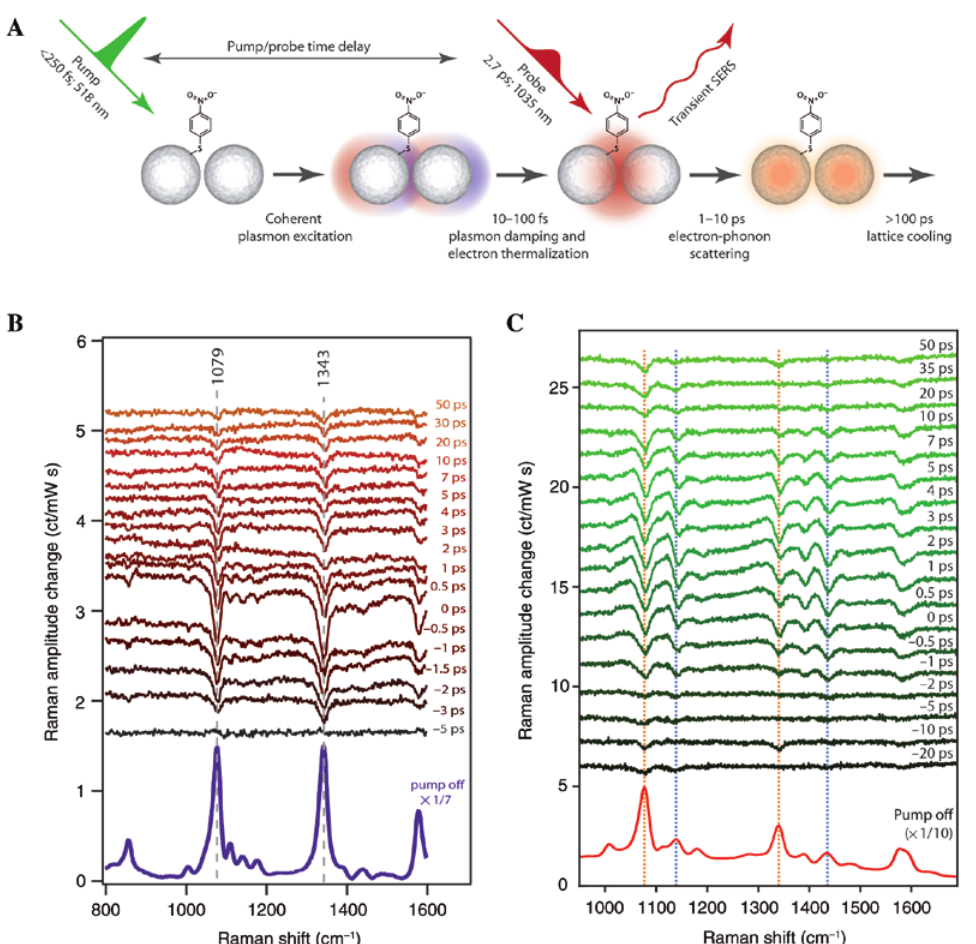
Figure 8: Ultrafast SERS probing of the photophysical responses of plasmon-molecule coupled systems. (A) Representation of the transient dynamics that ultrafast SERS is capable of measuring and tracking on aggregated AgNPs. (B) Ultrafast SERS describing the behavior of 4-NBT molecules as the AuNP’s plasmon experiences a photoinduced energy shift. (C) Fano-like signatures indicate that the energy transfer between the plasmon and the adsorbates is an indirect mechanism. (A and C) Reprinted with permission from Ref. [132]. Copyright 2016 American Chemical Society. (B) Modified with permission from Ref. [133]. Copyright 2017 American Chemical